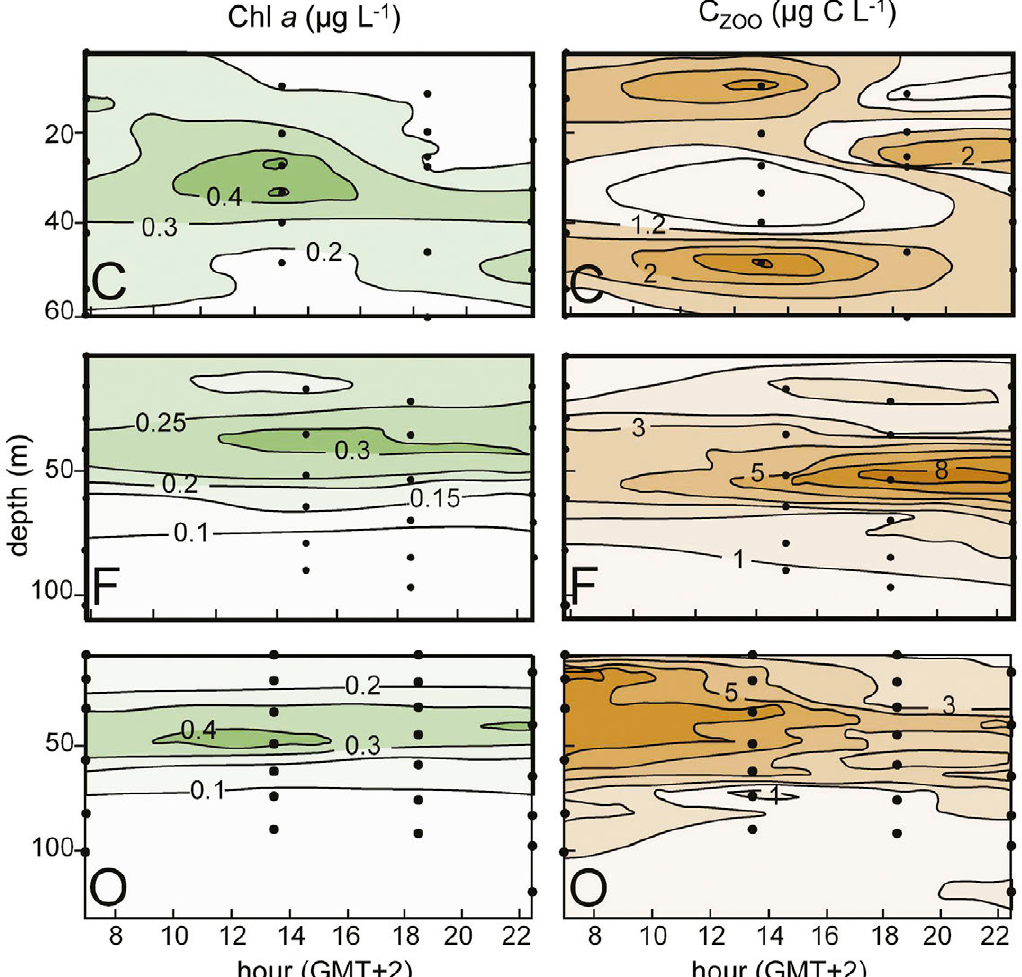
Fig. 4. – Chl a and C depth distribution at noon along a 24 h series for one of the legs (JD 162-164). The trends were similar for legs JD ZOO 154-156 and JD158-160. Horizontal axis, GMT+2; vertical axis, depth in m. C, F and O as in Figure